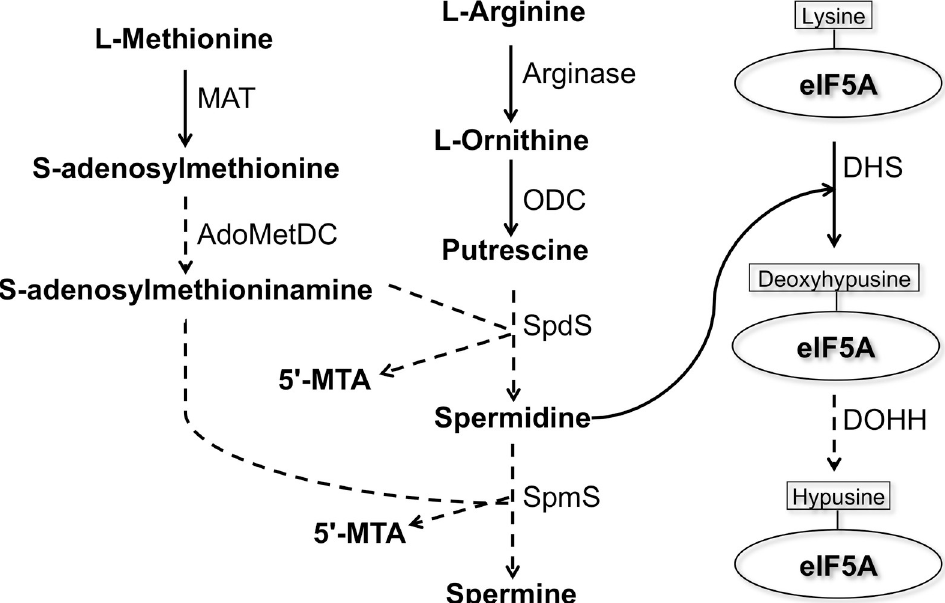
Fig 1. Presumed biosynthetic pathway of polyamines and deoxyhypusine/hypusine modifications on eukaryotic initiation factor 5A in E . histolytica . Solid lines represent the steps catalyzed by the enzymes whose encoding genes are present in the E . histolytica genome, whereas dashed lines indicate those absent or not yet identified. Abbreviations: 5’- MTA, 5’-methylthioadenosine; MAT, S-adenosylmethionine synthetase; ODC, ornithine decarboxylase, AdoMetDC, S- adenosylmethionine decarboxylase; SpdS, spermidine synthase; SpmS, spermine synthase; eIF5A, eukaryotic initiation factor 5A; DHS, deoxyhypusine synthase; DOHH, deoxyhypusine hydroxylase.